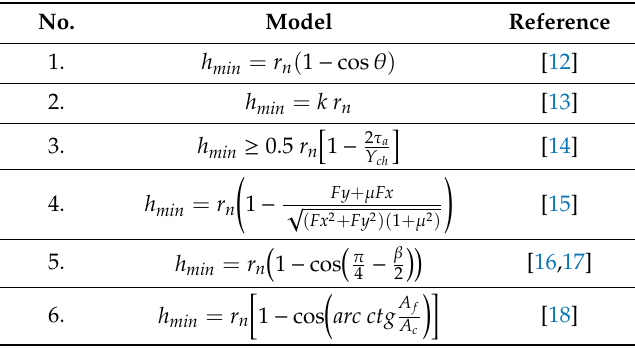
Table 1. Models used to calculate the minimum chip